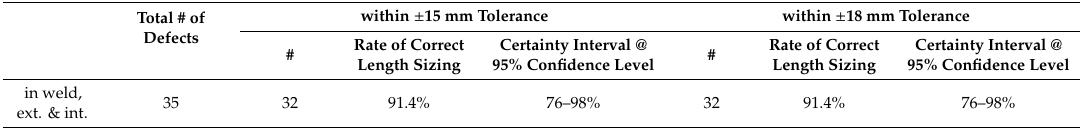
Table 4. Length sizing accuracy of defects in weld.